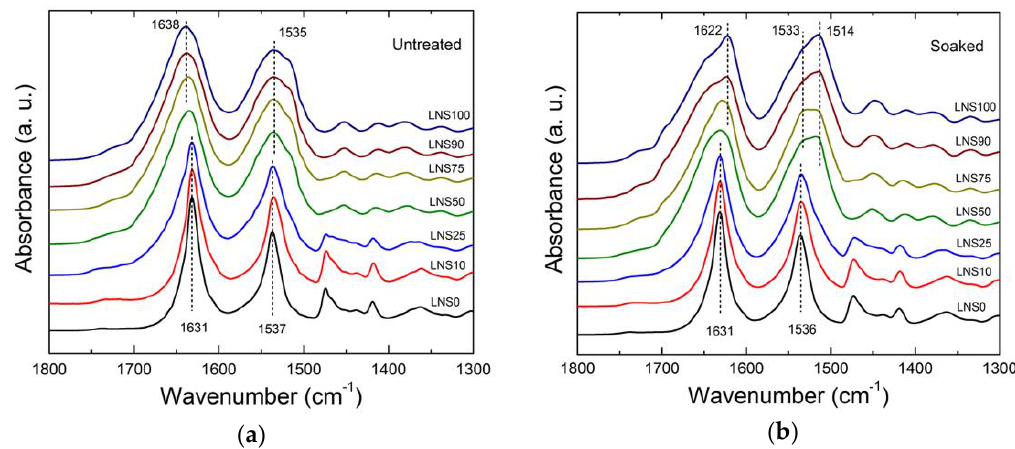
Figure 2. Fourier- transform infrared (FTIR) spectra of nylon610-silk (LNS) films ( a ) before and ( b ) after water bath treatment.